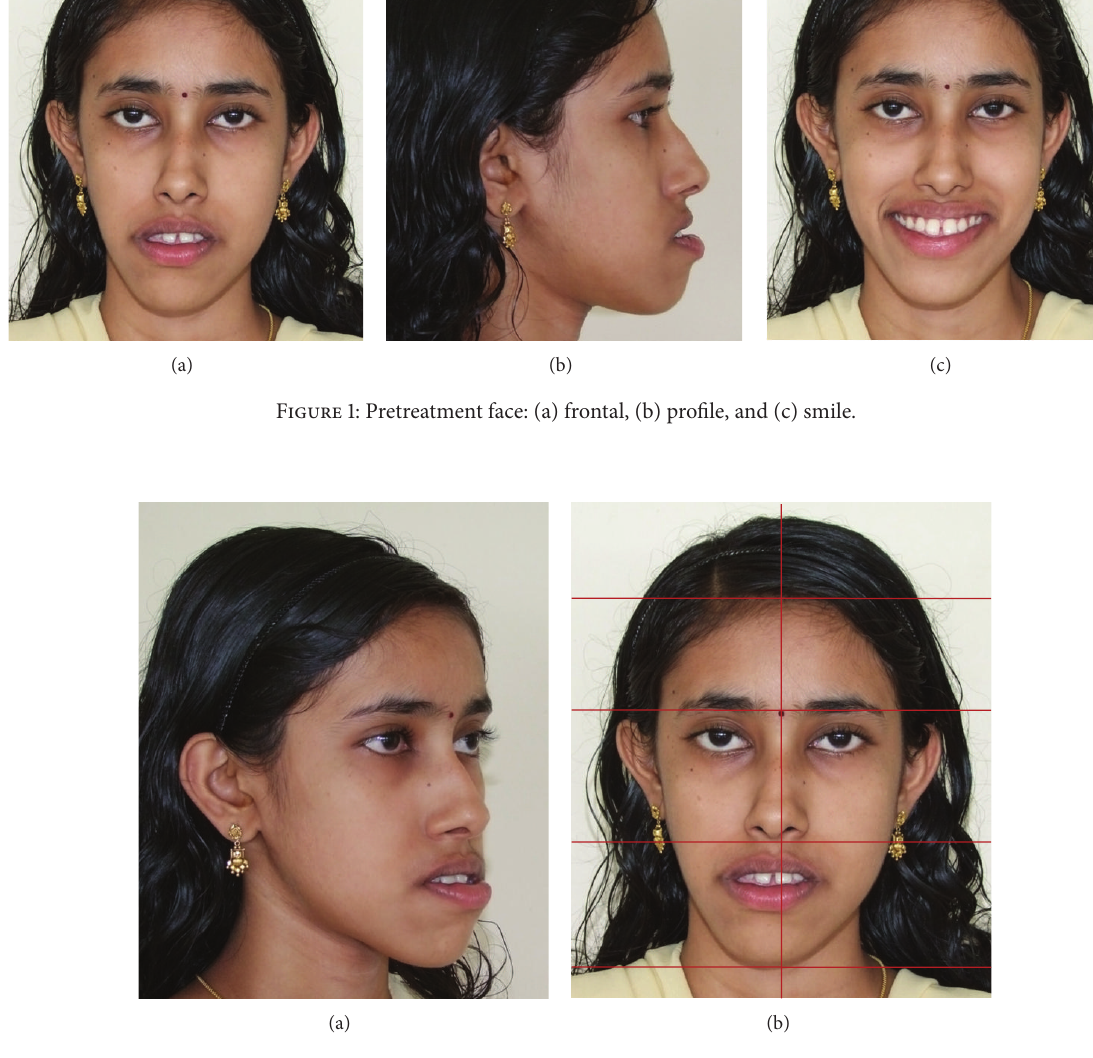
Figure 2: Pretreatment face: (a) oblique, and (b) vertical proportions and